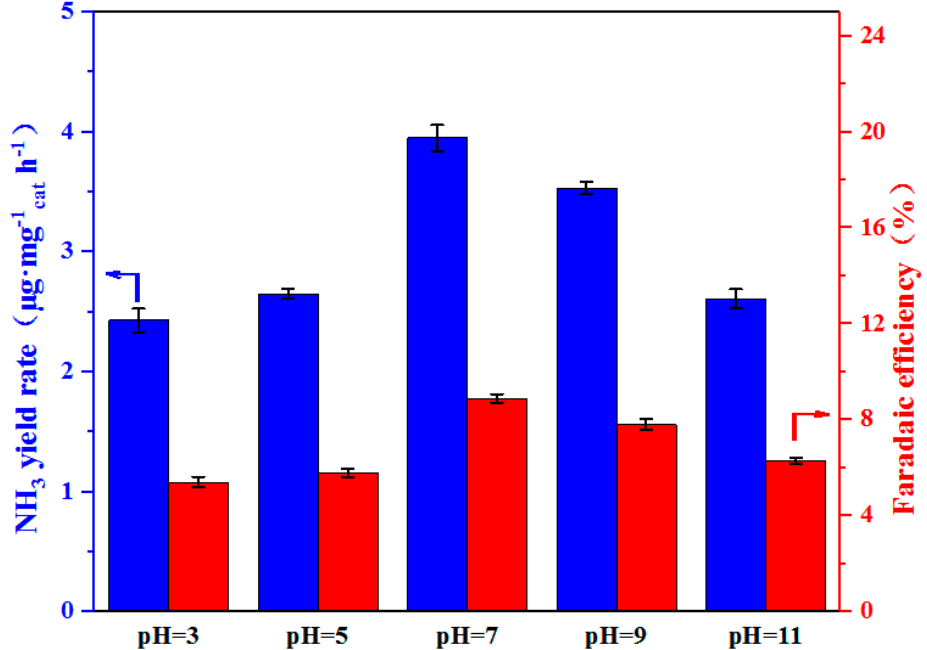
Figure 12. Ammonia synthesis rates and Faradaic efficiencies of Pd/ γ -MnO 2 prepared under different pH conditions.